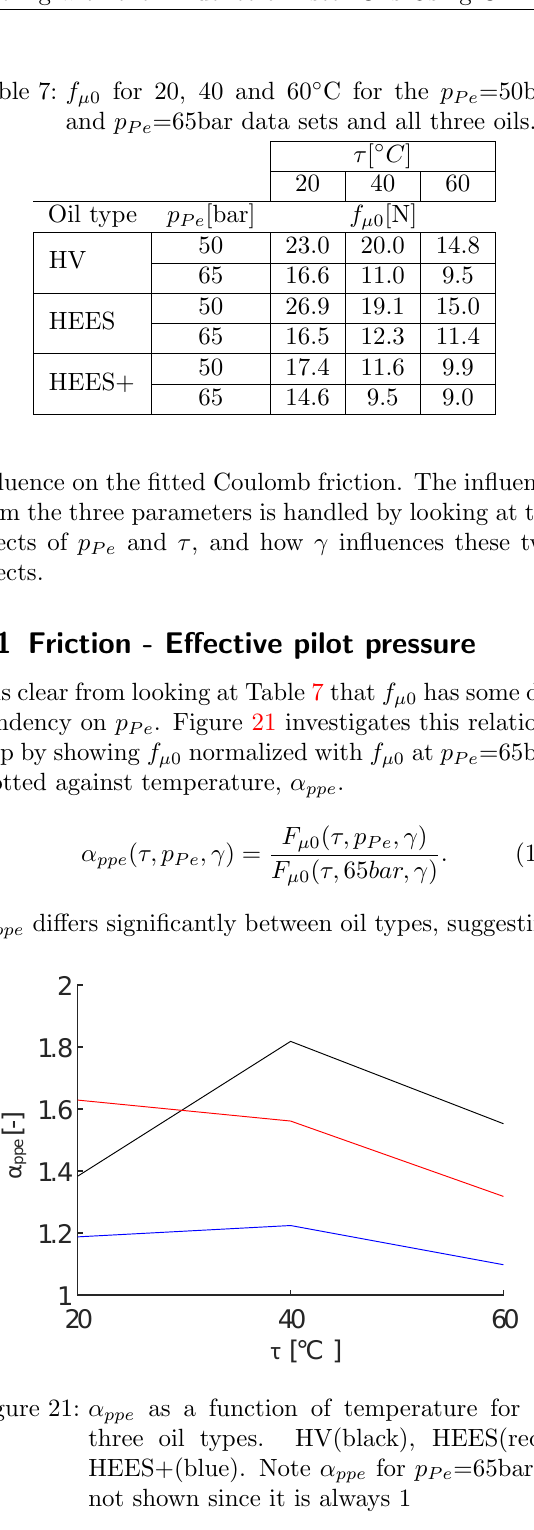
Figure 20: Model with friction(black), data(blue), Me- dian curve(gray) for HV at 40 ◦ C.